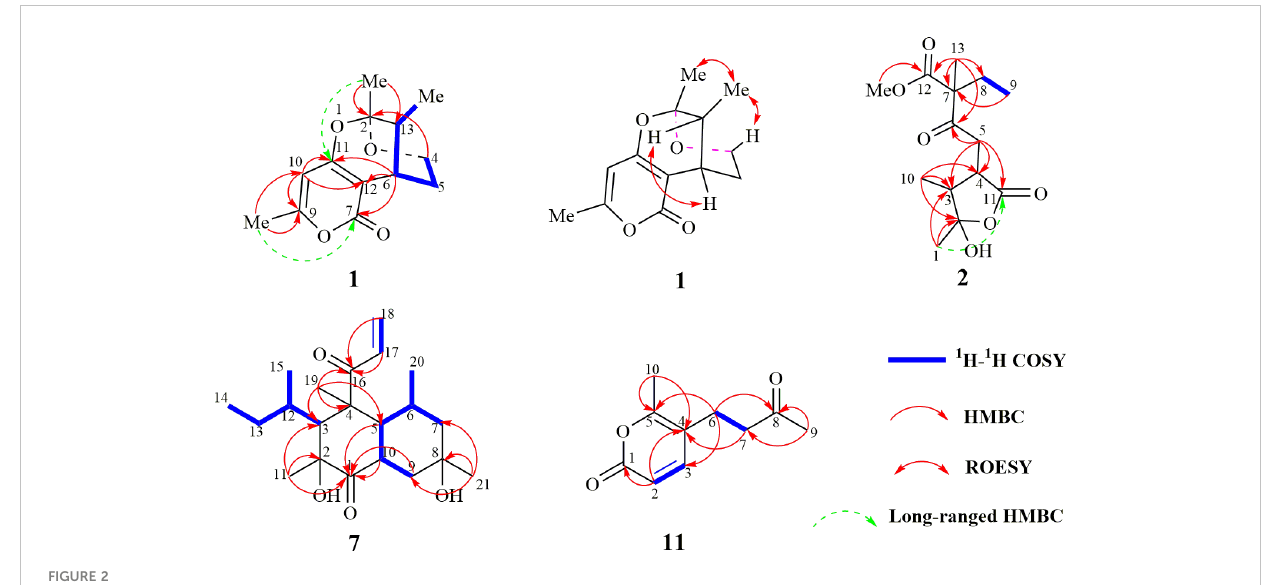
FIGURE 2 Key 2D-NMR correlations of compounds 1, 2, 7, and 11.